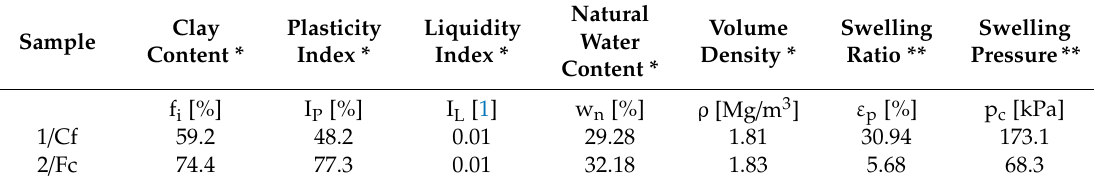
Figure 5. Geotechnical cross-section under the investigated overhead passage. Table 2. Swelling pressure value (p c ) and swelling ratio ( ε p ) for clays in a natural state from Bydgoszcz (after [20]).